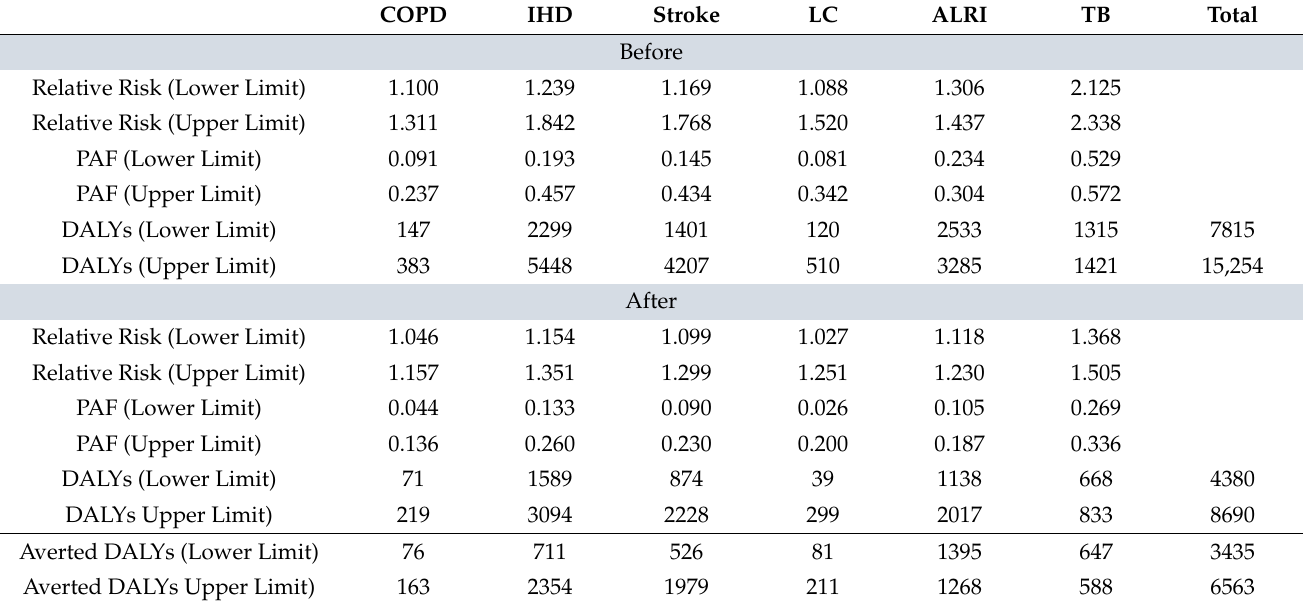
Figure 10 represents the combined co-benefits benefits from the intervention scenarios